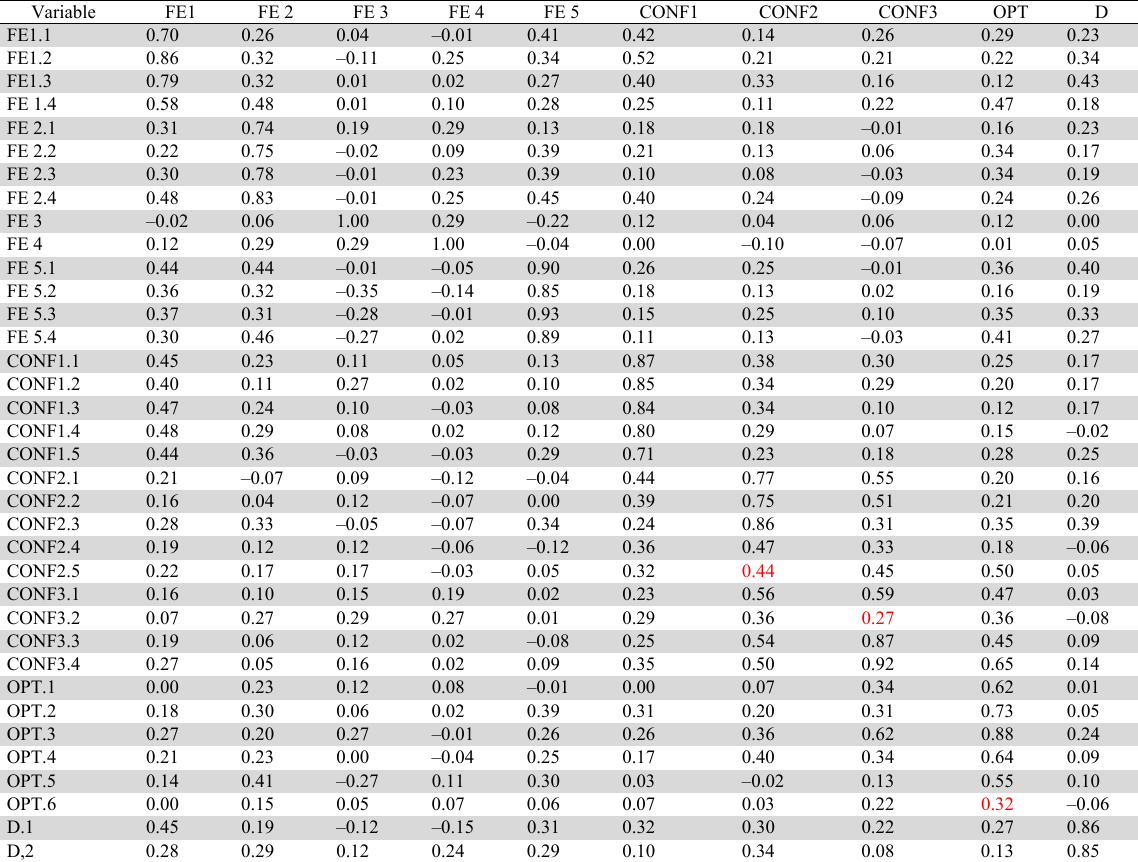
Summary of Statistical Analysis on Cross Loading Measurements (Model I) Variable